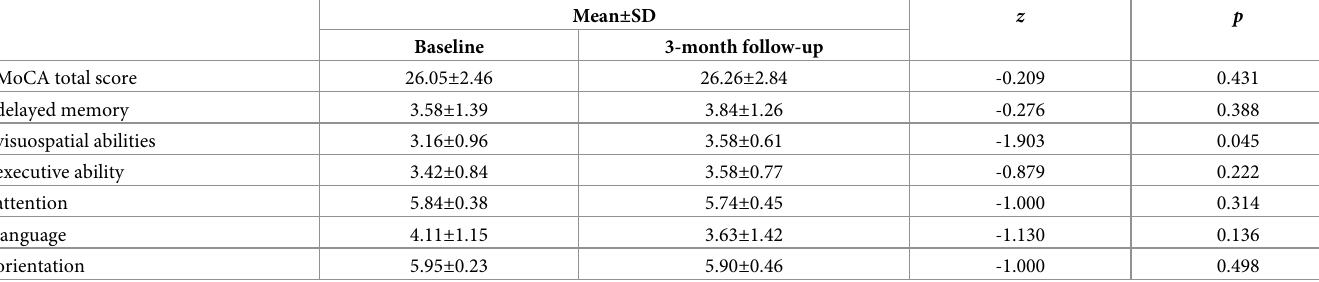
Table 3. Wilcoxon signed-rank test of MoCA scores between baseline and 3-month follow-up